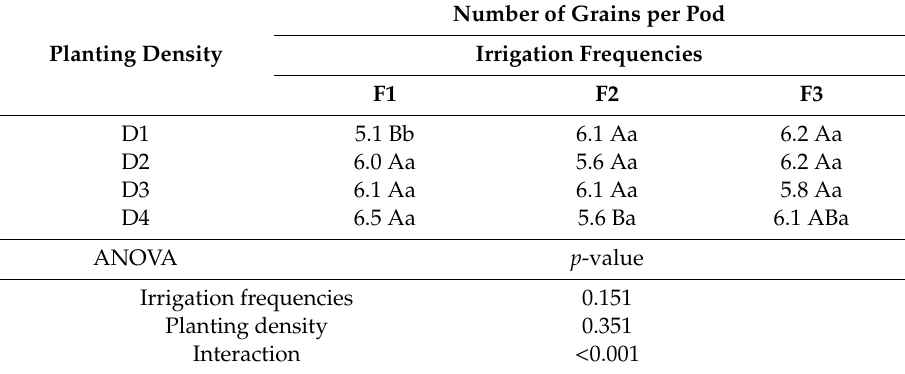
Table 5. Number of grains per pod of bean crop according to di ff erent irrigation frequencies and planting